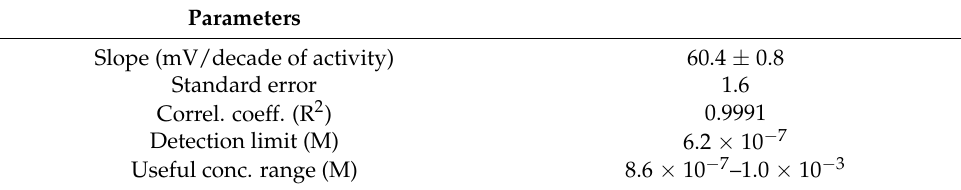
Table 2. The comparison of the performance of the new MWCNT-OSO 3 − TBZ + sensor with the performance of other potentiometric sensors for TBZ